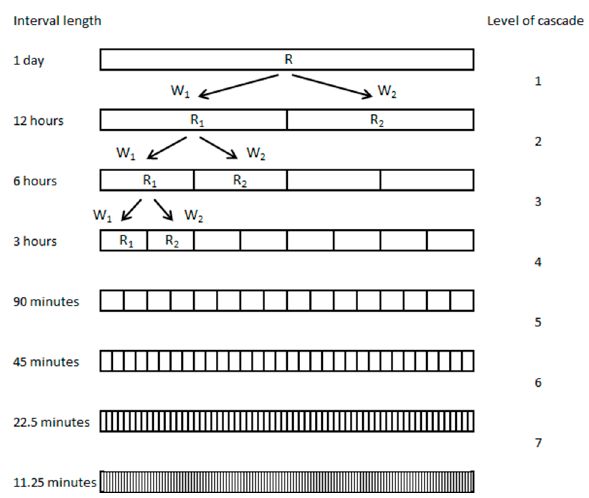
Figure 1. Schematic of the employed Multiplicative Discrete Random Cascade (MDRC), wherein daily data are disaggregated into 11.25 min data using seven cascade levels (from [6]; adapted from [1]).